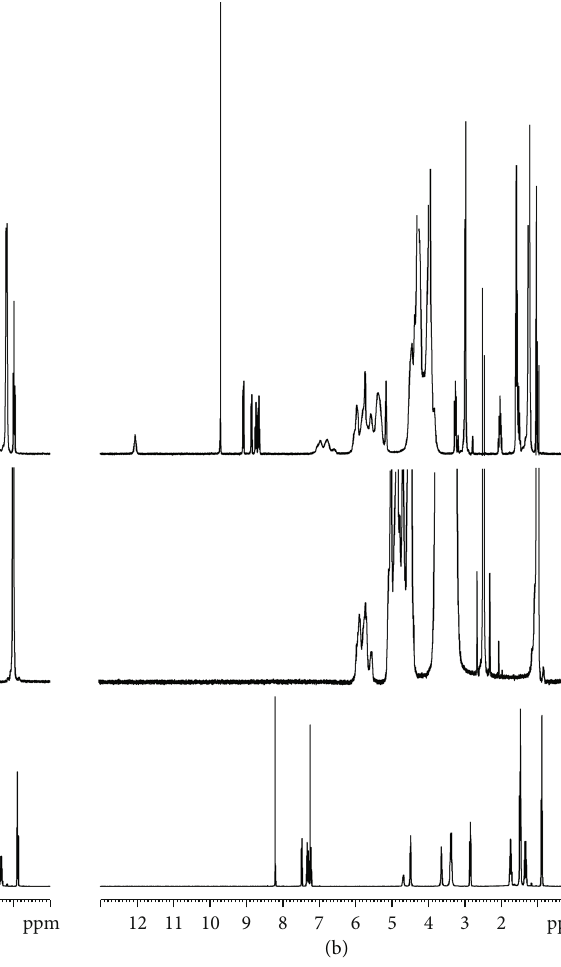
Figure 7: 1 H-NMR spectra of the complexes AMD/HP- β -CD A and AMD/HP- β -CD B and corresponding HP- β -CDs dissolved in DMSO- d6 and AMD dissolved in CDCl 3